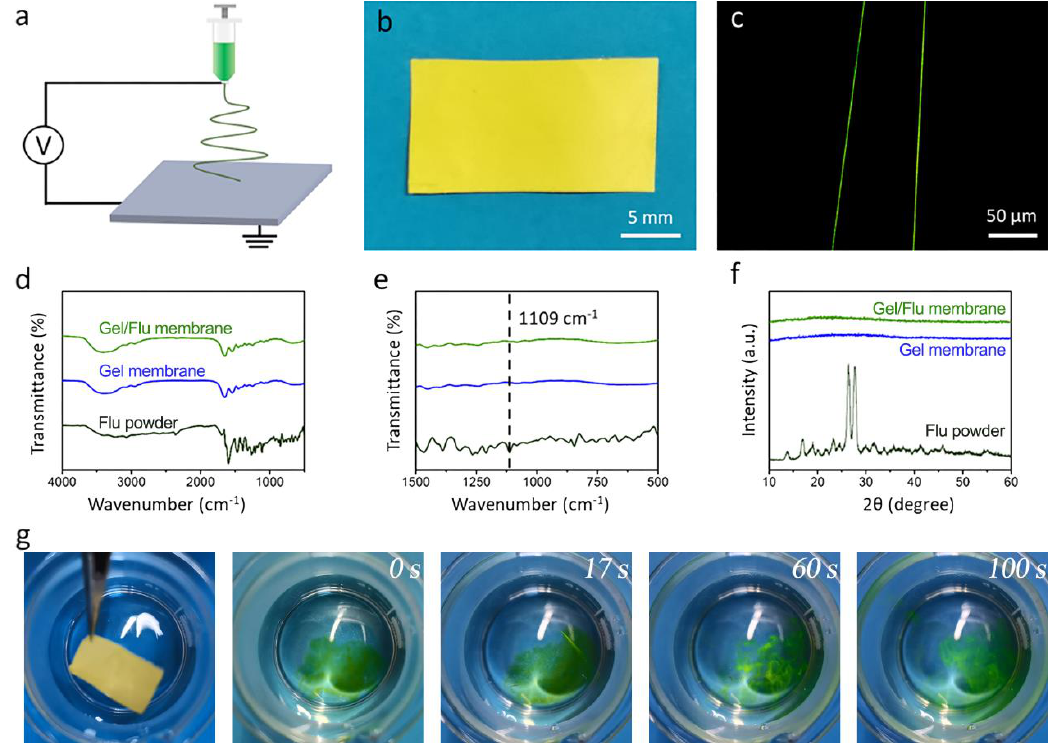
Figure 3. ( a ) Schematic illustration of the electrospinning equipment. ( b ) Optical image exhibiting the prepared sample of the Gel/Flu membrane. ( c ) Image of the Gel/Flu nanofibers from the flurescent microscope. ( d ) FTIR spectra and ( e ) Partial enlarged FTIR spectra. ( f ) XRD images of